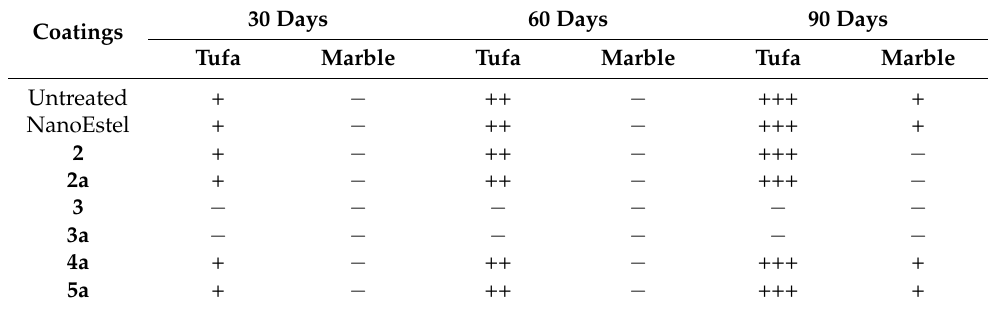
Table 4. Behavior of the different coatings applied on tufa and marble probes toward a spontaneous